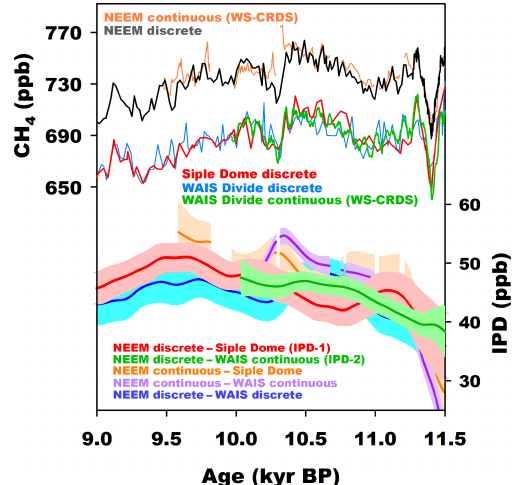
Figure 6. CH 4 inter-polar difference (IPD) and high-latitude CH 4 sources. Top: high-resolution CH 4 discrete measurements from NEEM discrete (black; Chappellaz et al., 2013), NEEM continuous (orange; Chappellaz et al., 2013), WAIS Divide discrete (light blue; WAIS Divide project members, 2015), WAIS Divide continuous (green; Rhodes et al., 2015), and Siple Dome (red, this study) ice core records. Bottom: 1000-year low-pass-filtered IPD reconstruc- tions by using various pairs of Greenland and Antarctic records, in which the IPD-1 and IPD-2 are shown in red and green, respectively. The shaded area indicates 95% significance interval.